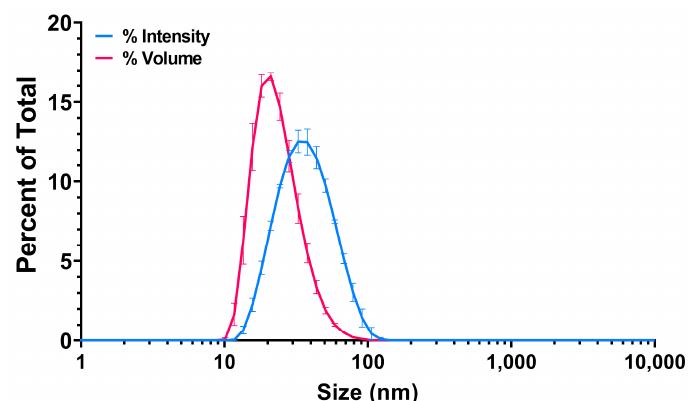
Figure 2. Intensity- and volume-weighted size distributions of carboxylated 25 nm polystyrene Figure 2. Intensity ‐ and volume ‐ weighted size distributions of carboxylated 25 nm polystyrene (PS25C) dispersed in water. (PS25C) dispersed in